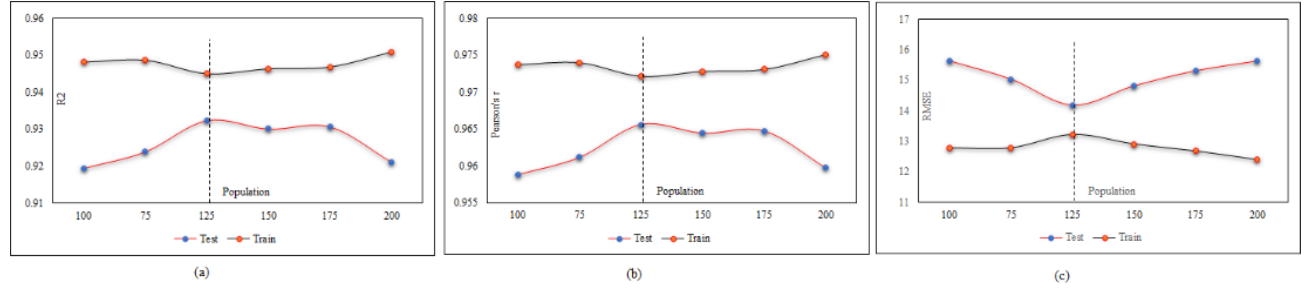
Figure 20. MPF adjustment based on the population number: ( a ) effect of the population number on ( R 2 ), ( b ) effect of the population number on (r), and ( c ) effect of the population number on ( RMSE ). Table 8. The calculated accuracy criteria for the performance of the implemented models (iterations = 40). Population